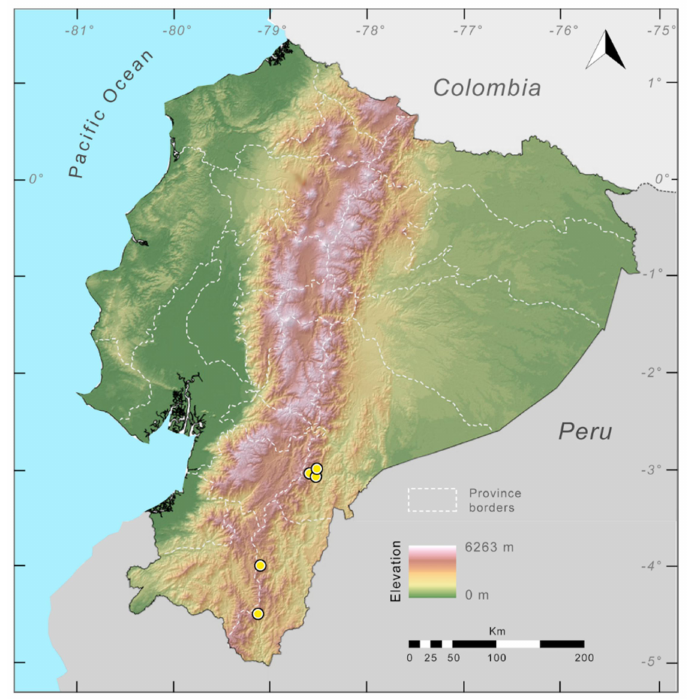
Figure 139. Distribution of Nymphargus cariticommatus in Ecuador (yellow